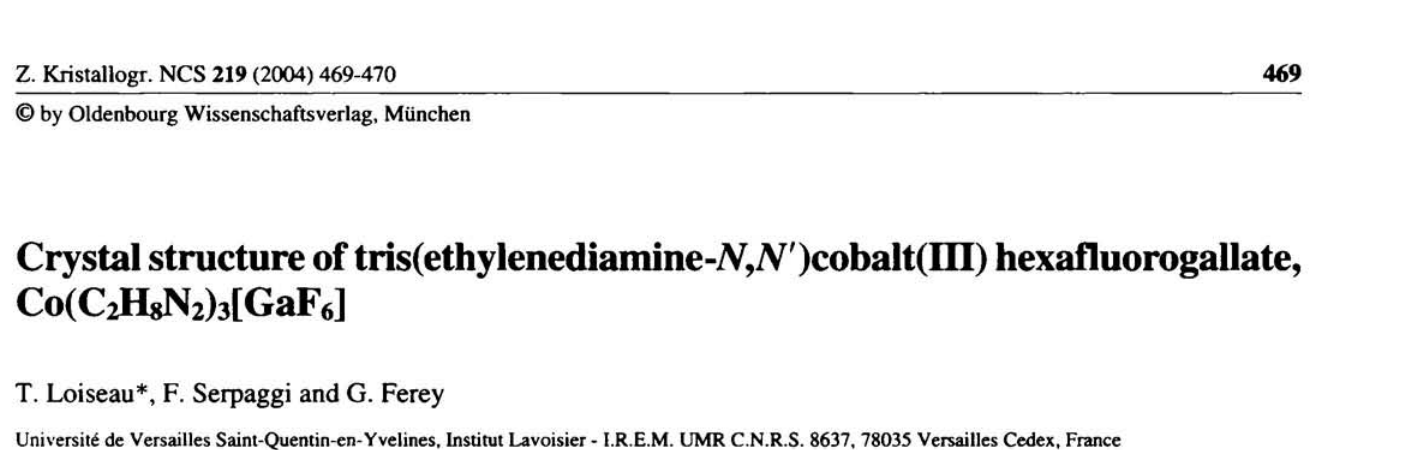
Table 1. Data collection and handling.